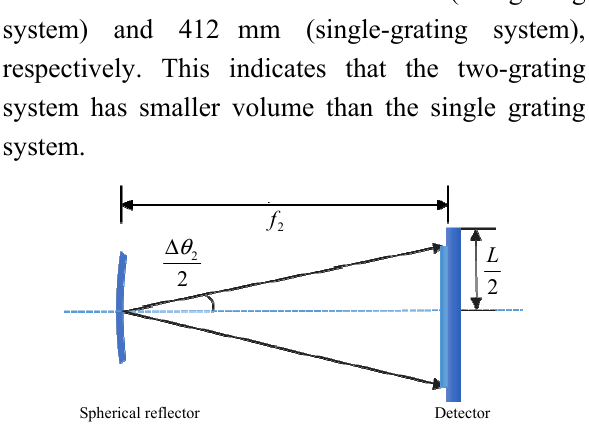
Fig. 3 Relationship between the focal length f 2 and the diffraction angle difference Δ θ 2 .